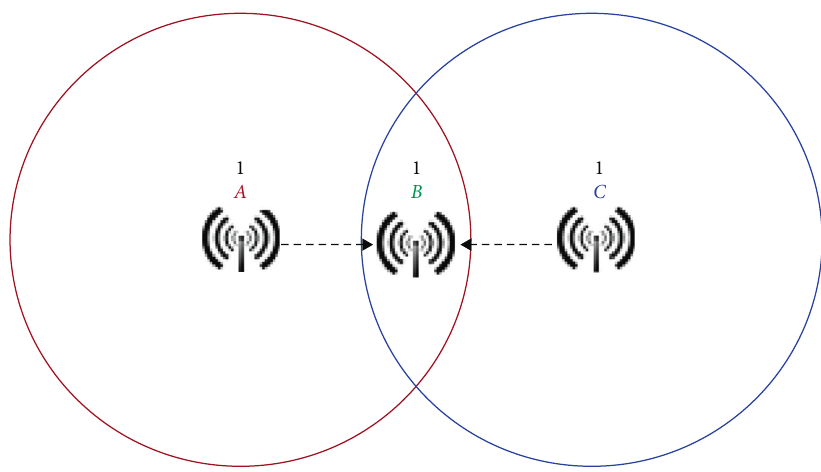
Figure 3: Interference at B due to A and C